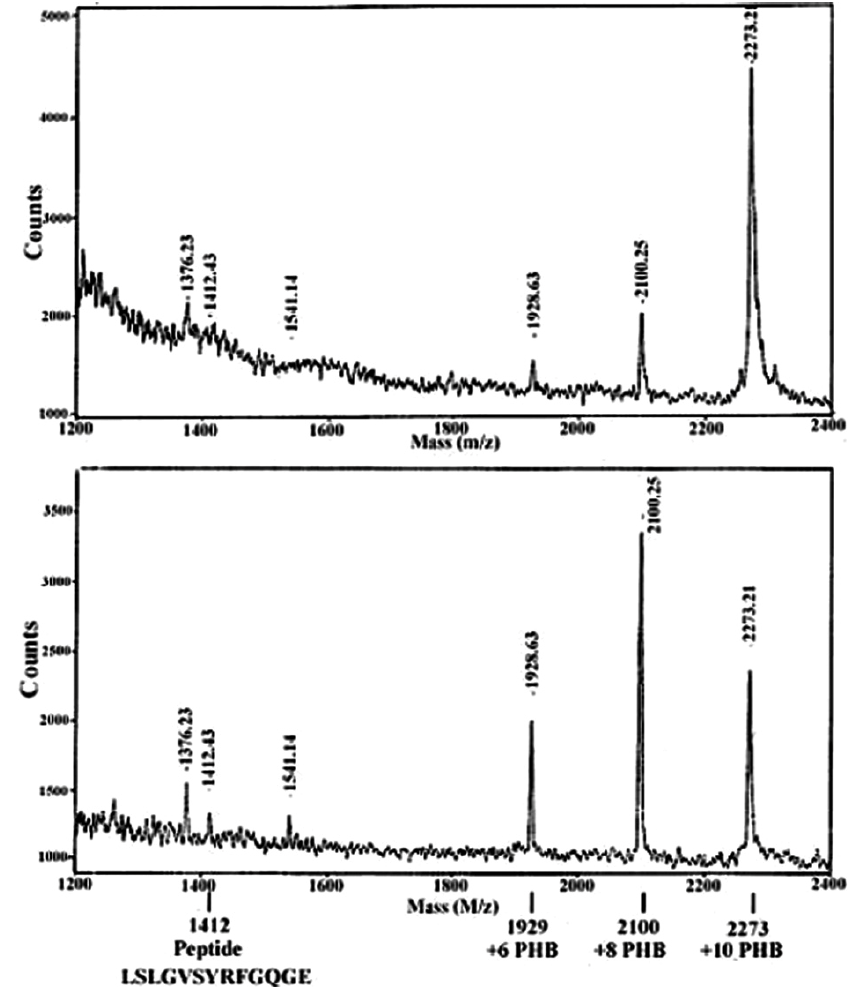
Figure 6. MALDI-MS of segment 162–174 of OmpA. Peptide LSLGVSYRFGQGE (162–174), obtained by cyanogen bromide and Staphylococcus aureus Glu-C digestion of wild-type OmpA. Matrix: a-cyano-4-hydroxycinnamic acid. MS analysis was performed using a Voyager Elite (Applied Biosystems) mass spectrometer in linear positive mode with a 50-ns delay. Laser strength was set to 1700 and low mass gate was set at 1000. Upper panel: initial spectrum. Lower panel: spectrum after ~3 additional seconds of the laser beam. From Xian et al. (2007)